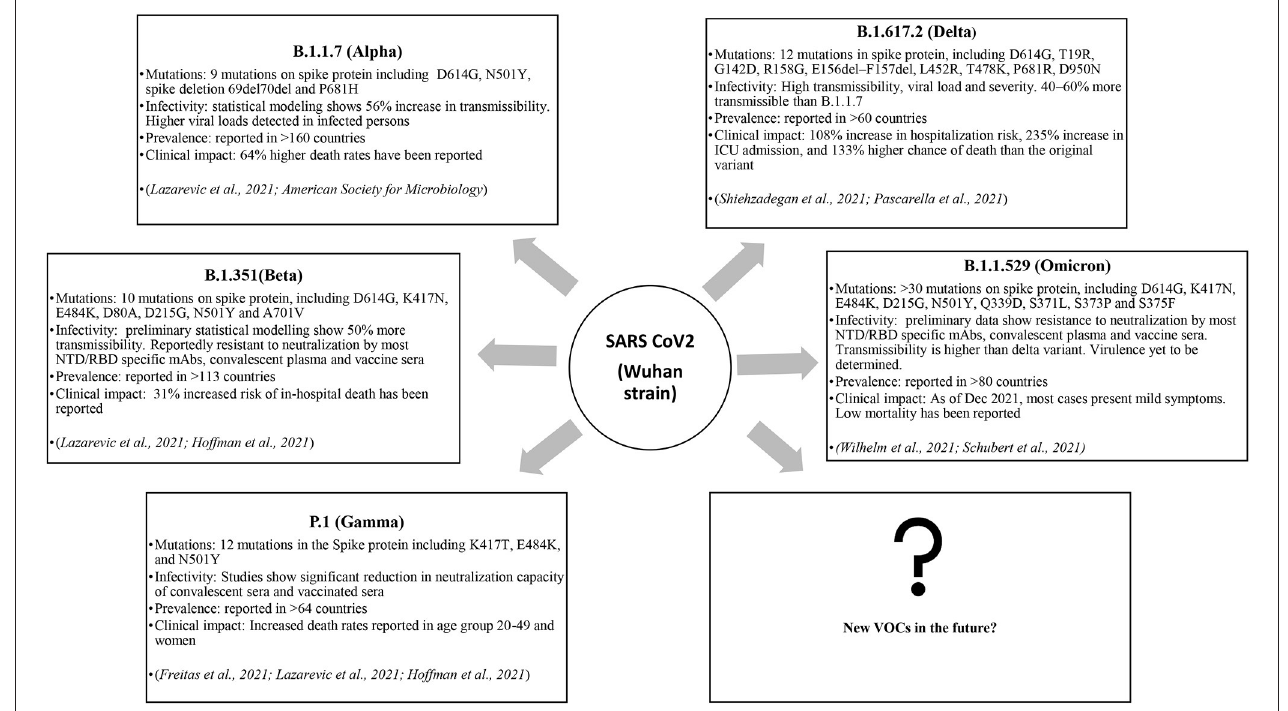
FIGURE 2 | The VOCs and their